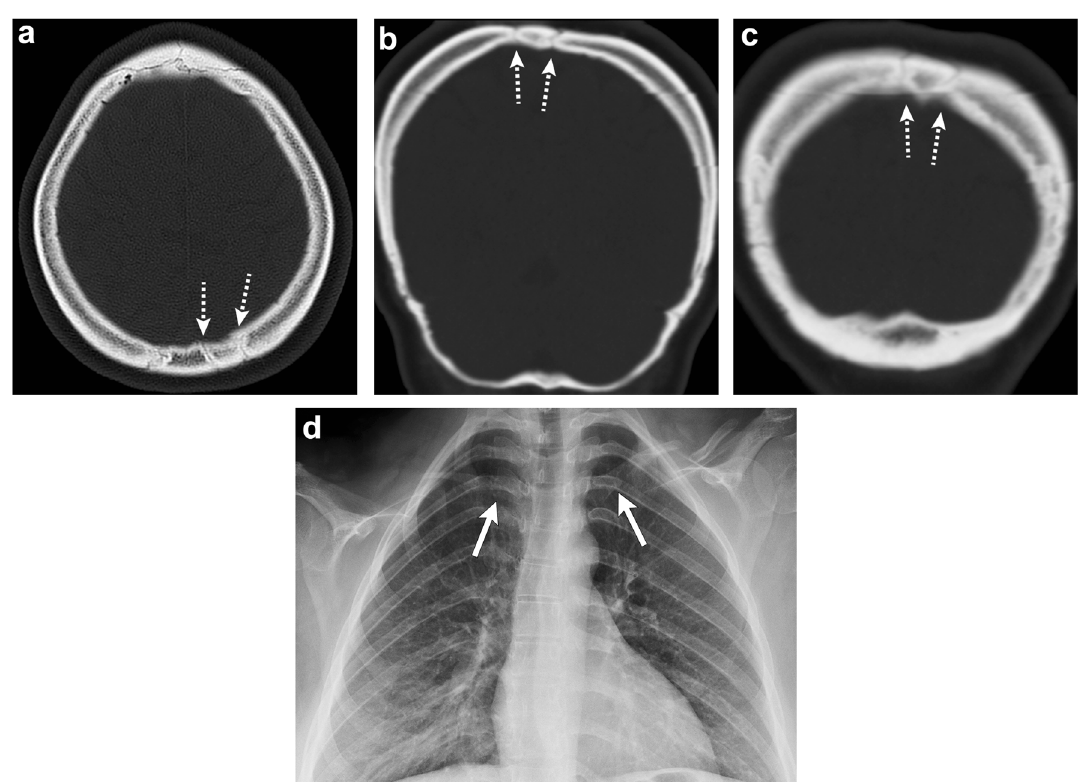
Fig. 15 Cleidocranial dysostosis. Axial ( a ) and coronal ( b , c ) head CT images show islands of intra-sutural bones ( dashed arrows ) in the lambdoid and sagittal sutures representing wormian bones. Chest